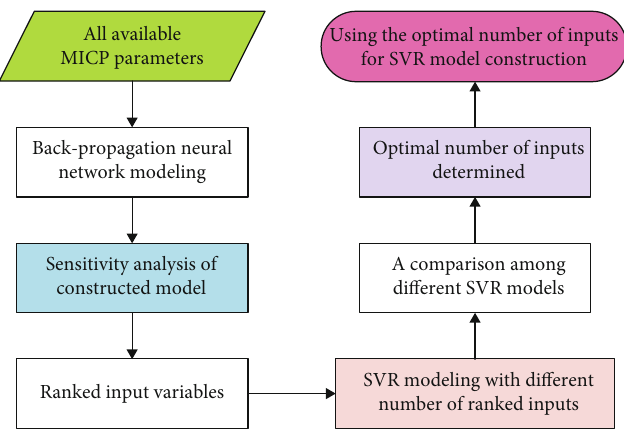
Figure 4: Flowchart explaining the input variable selection by the sensitivity analysis